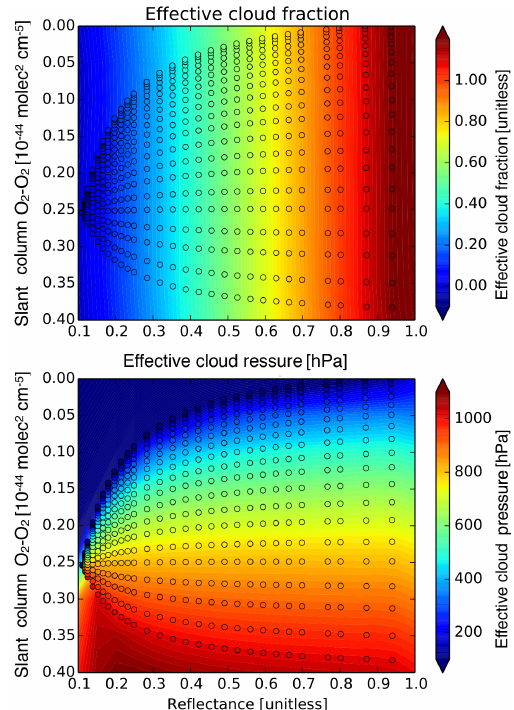
Figure 2. Example of a slice of the effective cloud fraction LUT (top panel) and effective cloud pressure LUT (bottom panel), show- ing the LUT value as a function of the continuum reflectance R c and the slant column O 2 –O 2 N s , O . The background colours show 2 O 2 the values in the LUT derived from interpolation and extrapolation of the DOAS fit results, which are shown as the colour-filled sym- bols. The other LUT nodes are fixed to the following values: solar zenith angle of 44.2 ◦ , viewing zenith angle of 21.2 ◦ , relative az- imuth angle of 0.0 ◦ , surface albedo of 0.05 and surface altitude of